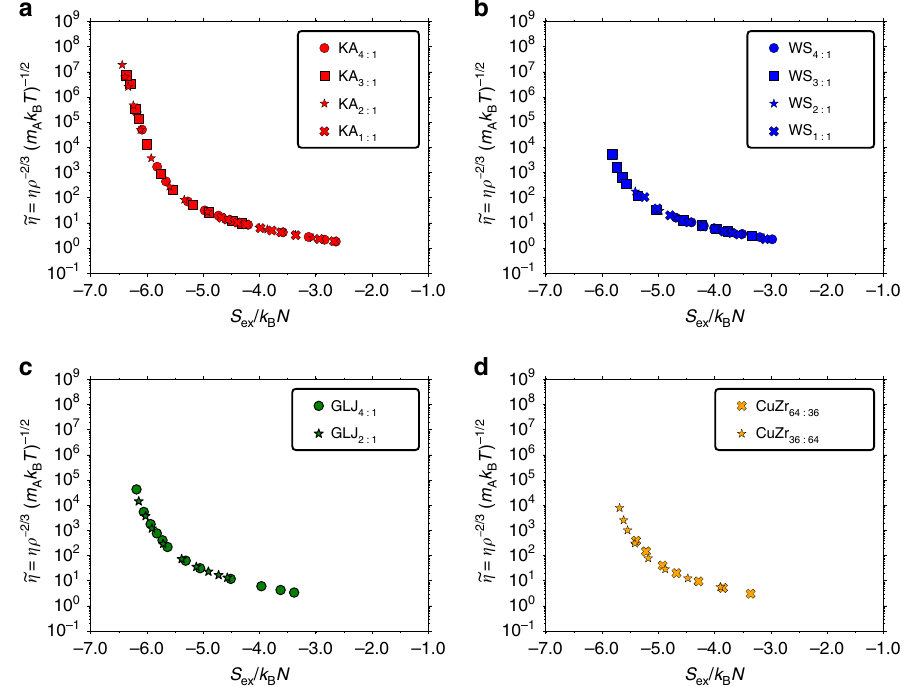
Fig. 2 Reduced viscosity e η as a function of S ex for several mixtures and compositions. A universal curve is observed for each system with excess entropy. a KA mixtures. ρ = 1.204 for 4:1, ρ = 1.400 for 3:1, ρ = 1.400 for 2:1, ρ = 1.450 for 1:1. b WS mixtures. ρ = 1.000 for 4:1, ρ = 1.100 for 3:1, ρ = 1.100 for 2:1, ρ = 1.296 for 1:1. c GLJ mixtures. ρ = 1.200 for 4:1, ρ = 1.350 for 2:1. d CuZr mixtures. ρ = 0.08 Å − 3 for both